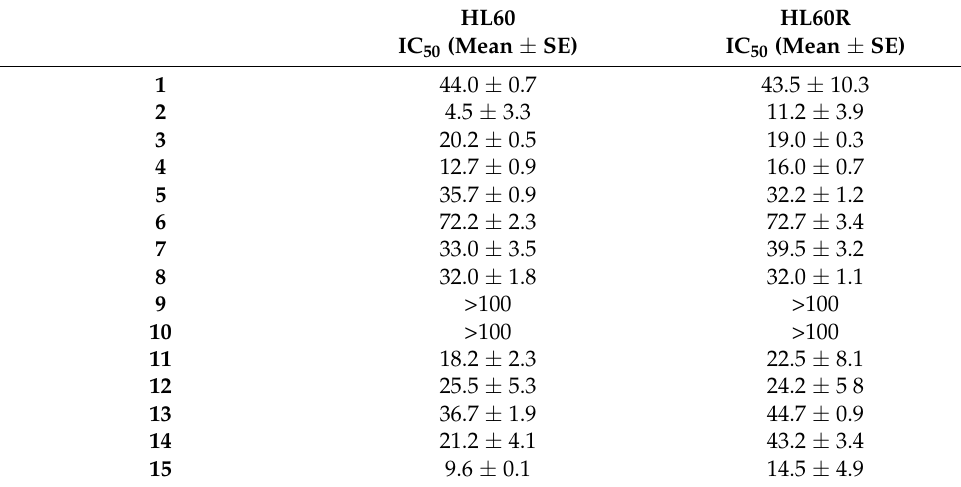
Table 3. IC 50 values of cell lines treated with